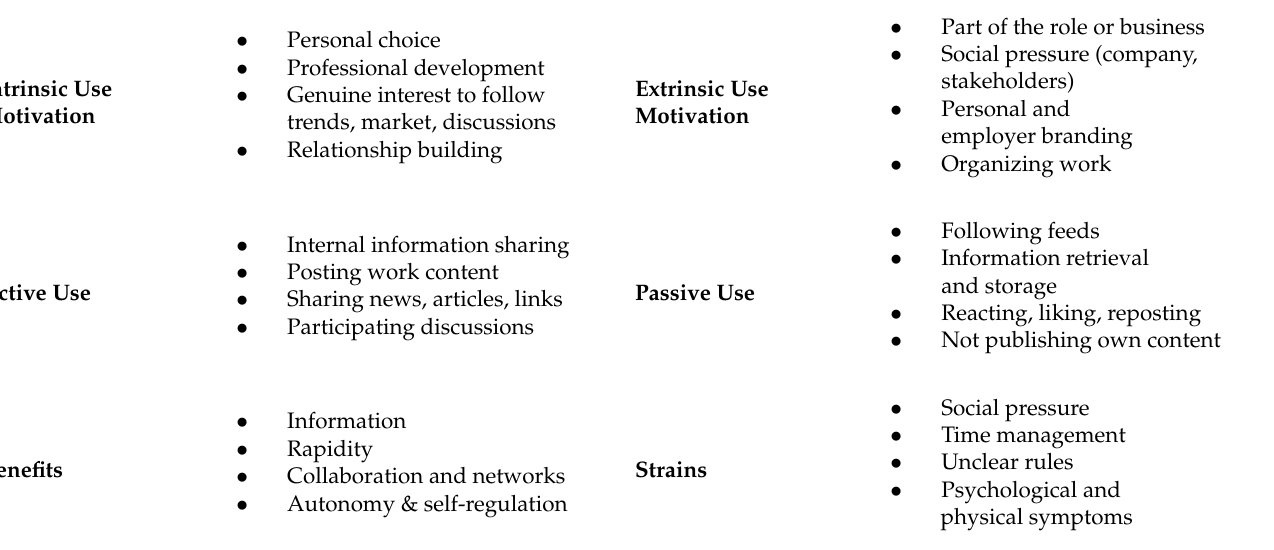
Table 3. Millennials’ social media use at